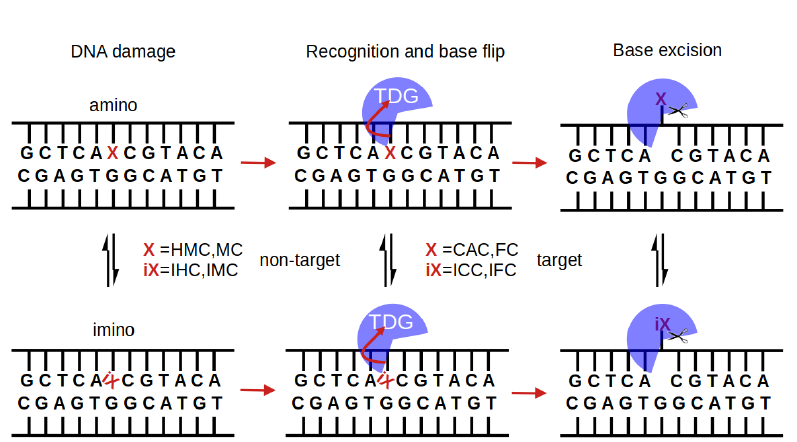
Figure 1. Multi-step interrogation pathway of TDG for recognition of target bases X. In their imino form (iX), the bases form a wobble pair with the G on the complementary strand (indicated by a tilted iX), which is envisaged to facilitate extrusion of the target base and flipping it into TDG’s active site [11,21,22]. This base flip site is a pre-requisite for the chemical step of base excision by glycosidic bond cleavage and crystal structures clearly show TDG-DNA complexes with the target base in an extrahelical conformation [6–8]. FC and CAC and their respective imino forms, IFC and ICC, are targets of TDG whereas MC and HMC (or their imino forms, IMC and IHC, respectively) are not. Discrimination between target and non-target base can in principle occur at any of the steps (protein binding, base flip, bond cleavage) and with the base in amino or imino form, though the amino form dominates in unbound DNA